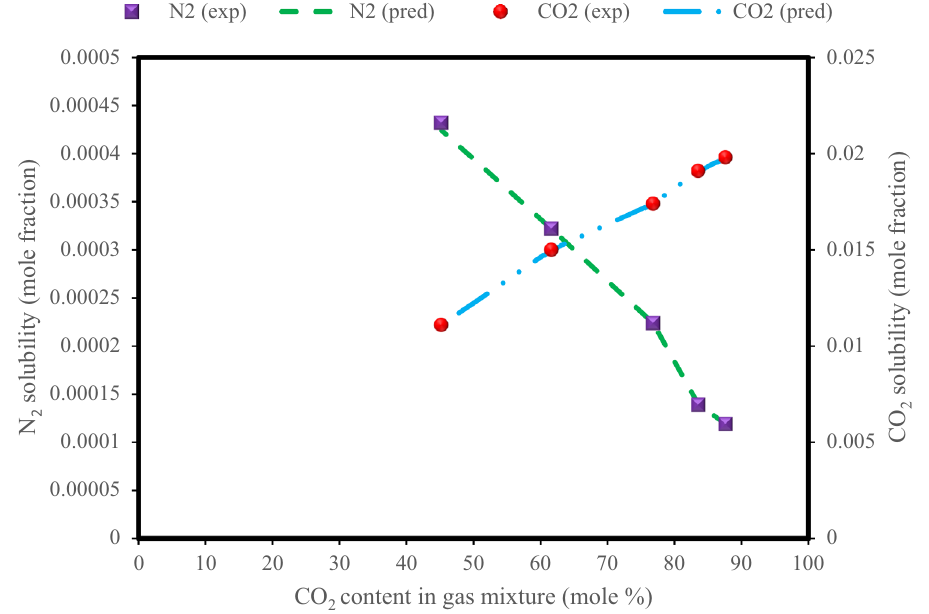
Figure 8. Dependence of CO 2 and N 2 solubilities on the mole percent of CO 2 in the gaseous phase in the N 2 + CO 2 + H 2 O system at a temperature of 308 K and pressure of 8.0 MPa.